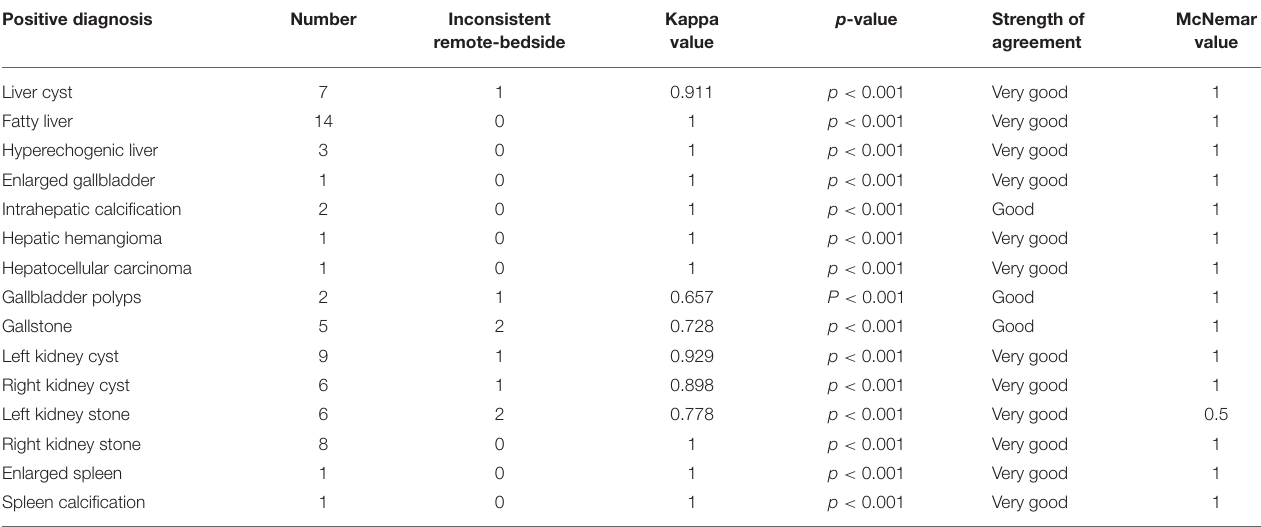
TABLE 3 | Comparison between bedside and remote ultrasound